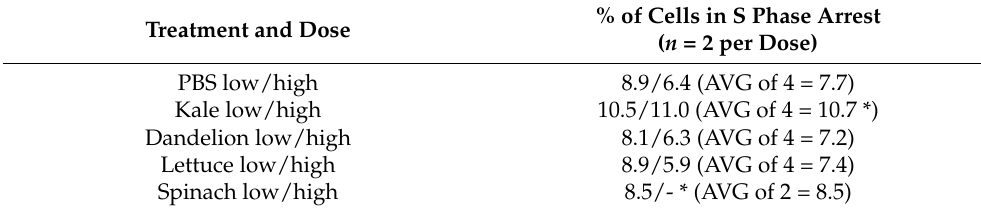
Table 1. Propidium iodide-stained flow cytometric analysis of SH-SY5Y cells given different juices for 24 h. Low dose is 0.7% and high dose is 4.2% juice. Values are the means from different experiments on different days. * Determined to be statistically significant, p < 0.05 ( n = 4; paired t test). Treatment and